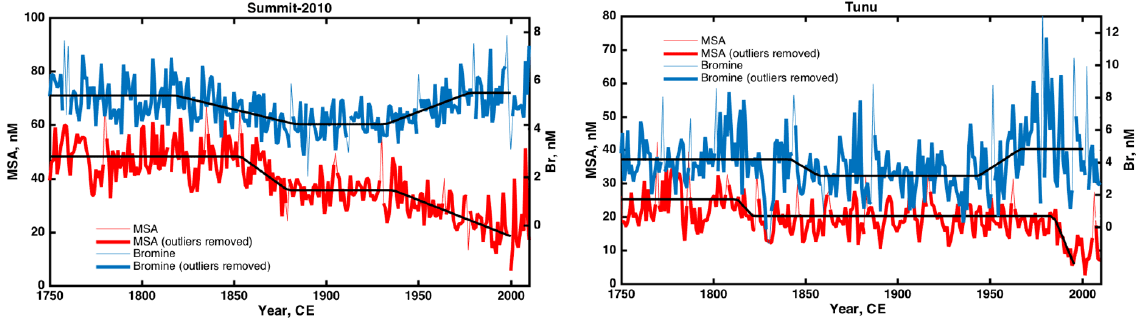
Figure 2. Annual record of bromine (thin blue) and MSA (thin red). Annual record of bromine (thick blue) and MSA (thick red) with outlying spikes removed using a 25-year running average filter described by Sigl et al. (2013). All records were fit with a three-step linear regression (black) and the results of the fits which identify the timing of inflection points are summarized in Table S1. The time series have been plotted to match the signal variability in the pre-industrial era